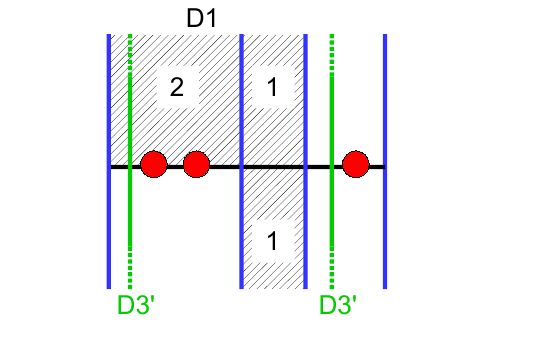
Figure 32 . Products of CB operators are inserted by adding several D1 strings and D3" branes to the setups. a) n semi D1s inserting ( u + ) n , b) m D3"s inserting ’ m , c) One semi D1 and two D3"s inserting u + ’ 2 .